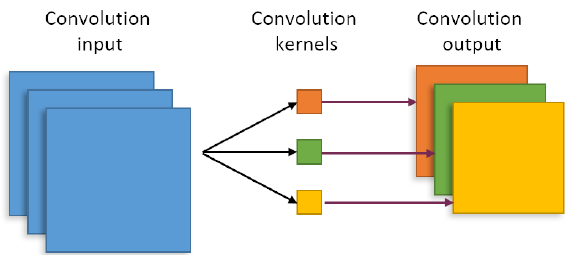
Figure 1. Schematic diagram of the convolution operation. The output of different colors represents the result obtained after the input data are convolved through the convolution kernel of the corre- sponding color. After only performing the convolution operation on the input data, the size of the output result is smaller than that of the input